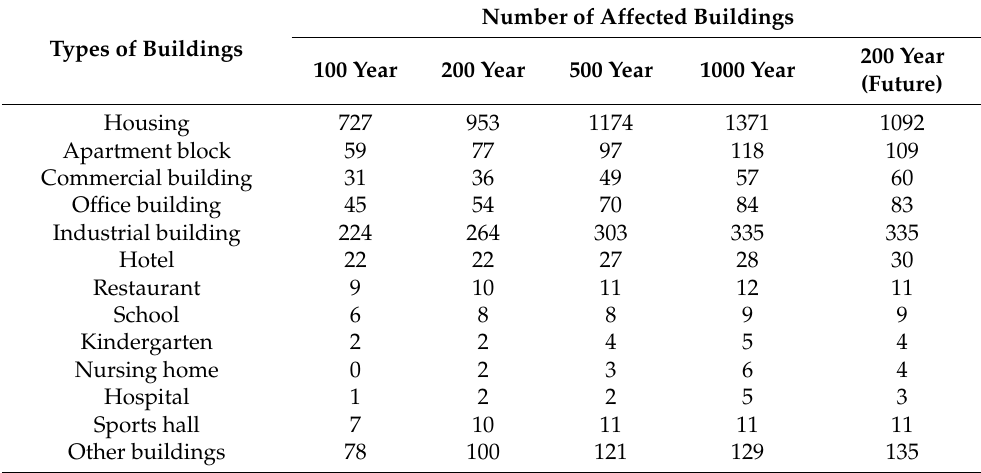
Table 7. The number of flood-affected buildings at various recurrence